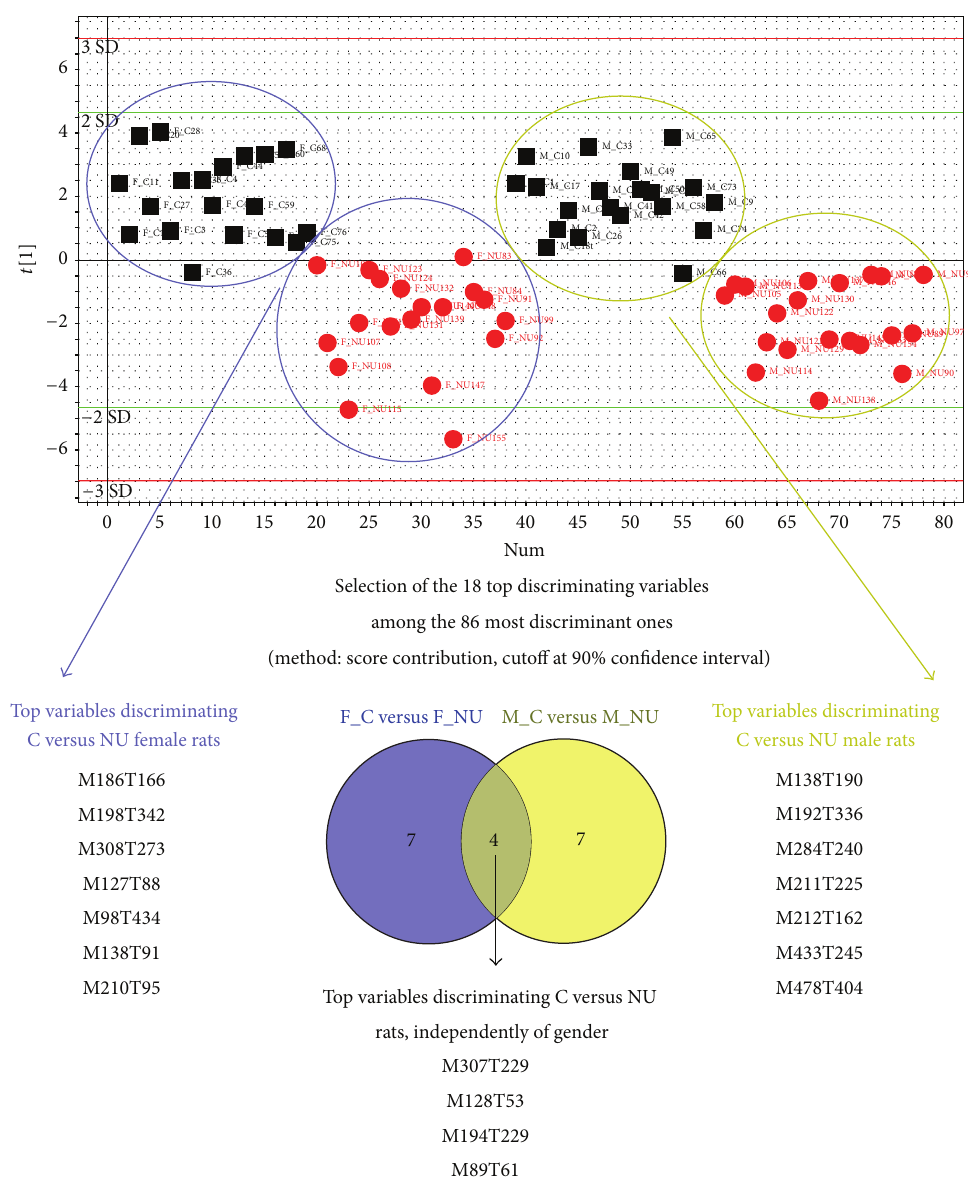
Figure 7: Principal component analysis of the 85 most discriminatory CSF metabolites in male and female rats, control or those exposed to 40 mg ⋅ L −1 NU from birth for 9 months (PLSDA model built with the 1244 CSF metabolites followed by a hierarchic ascendant classification). C: control; NU: natural